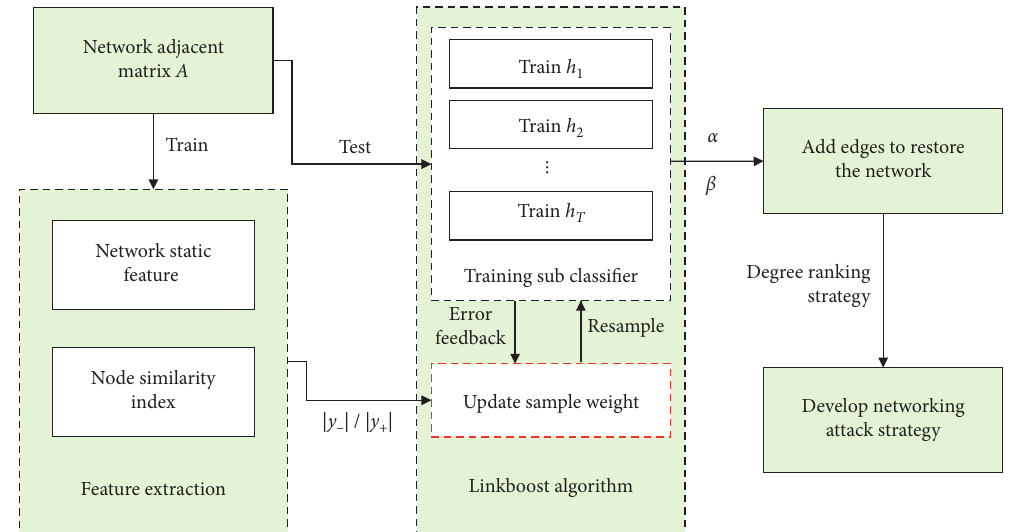
Figure 3: Overview of the Linkboost